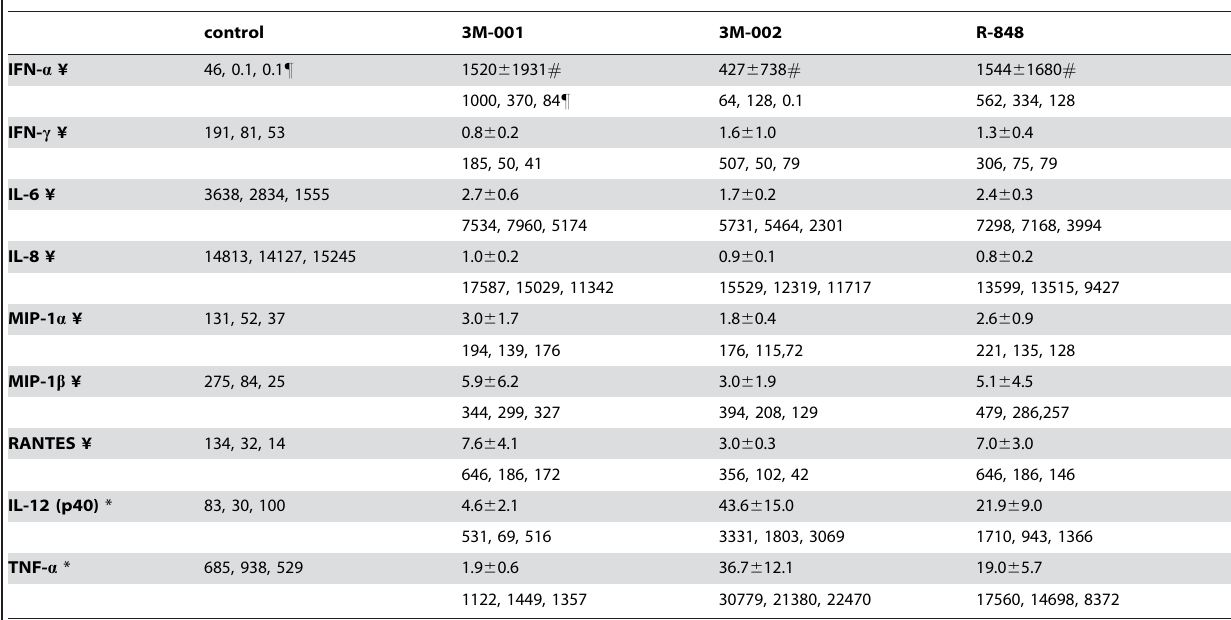
Table 4. Induction of cytokines one day after triggering TLR7 and/or 8 in PBMC; indicated in each box upper line are the average 6 std fold induction # and lower line the corresponding absolute concentrations of cytokines measured in the supernatant [pg/ml] (n= 3) "